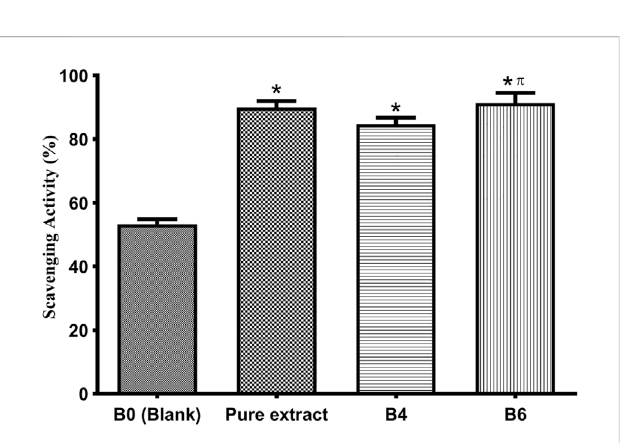
FIGURE 6 Antioxidant activity of the pure extract, optimized formulations (B4 and B6), and blank (B0). Error bar represents the standard deviation (n = 3; p -value ˂ 0.05, *compared with Blank, and π compared with